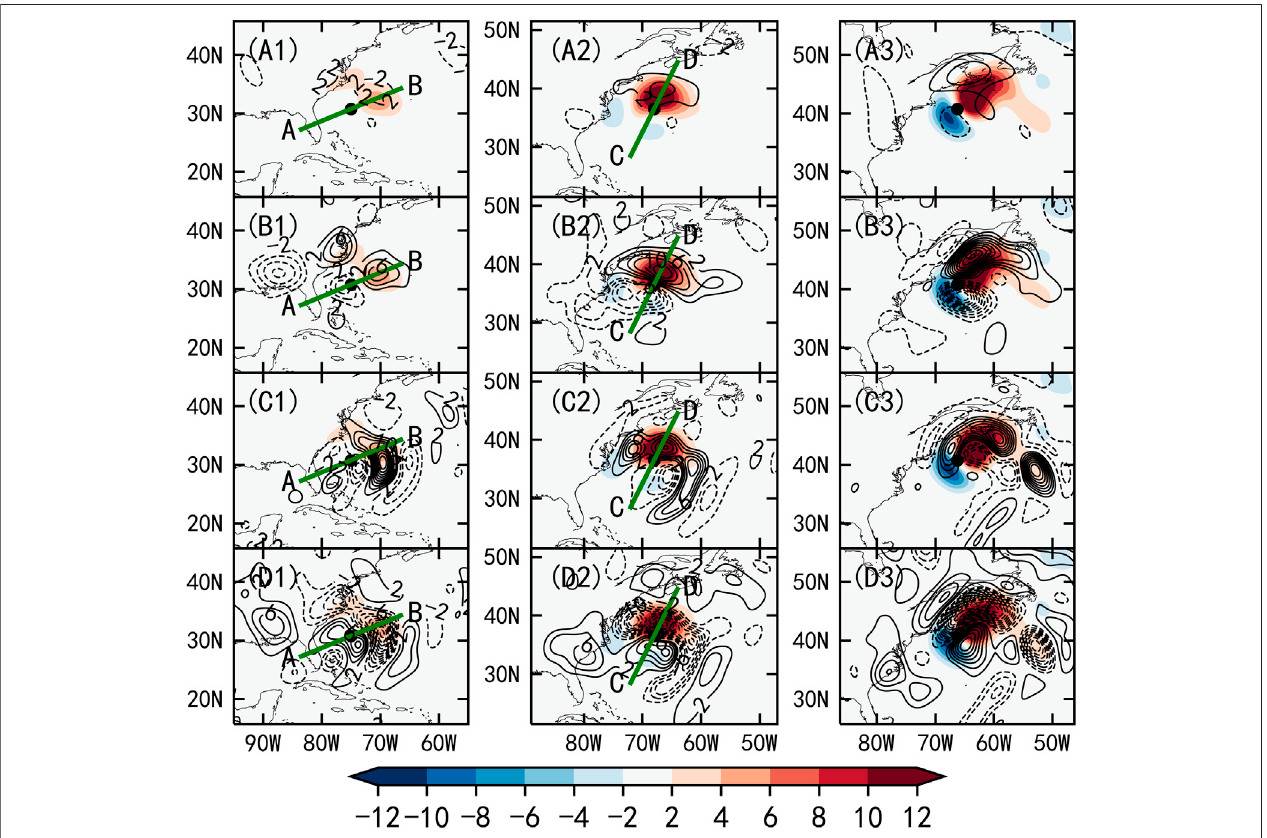
FIGURE 5 | Contributions of individual terms (contours, 2 × 10 − 9 s − 2 intervals) to the total tendency (shaded, 2 × 10 − 9 s − 2 intervals) at (A1 – D1) 18 UTC 25, (A2 – D2) 06UTC 26,and (A3 – D3) 18UTCMarch 26, 2014.Thelargesoliddotdenotes theSEC center. (A1 – A3) thecyclonic-vorticity advection, (B1 – B3) thewarm-air advection, (C1 – C3) the diabatic heating, (D1 – D3) the adiabatic heating. The lines of A – B and C – D are the cross sections in Panel 7